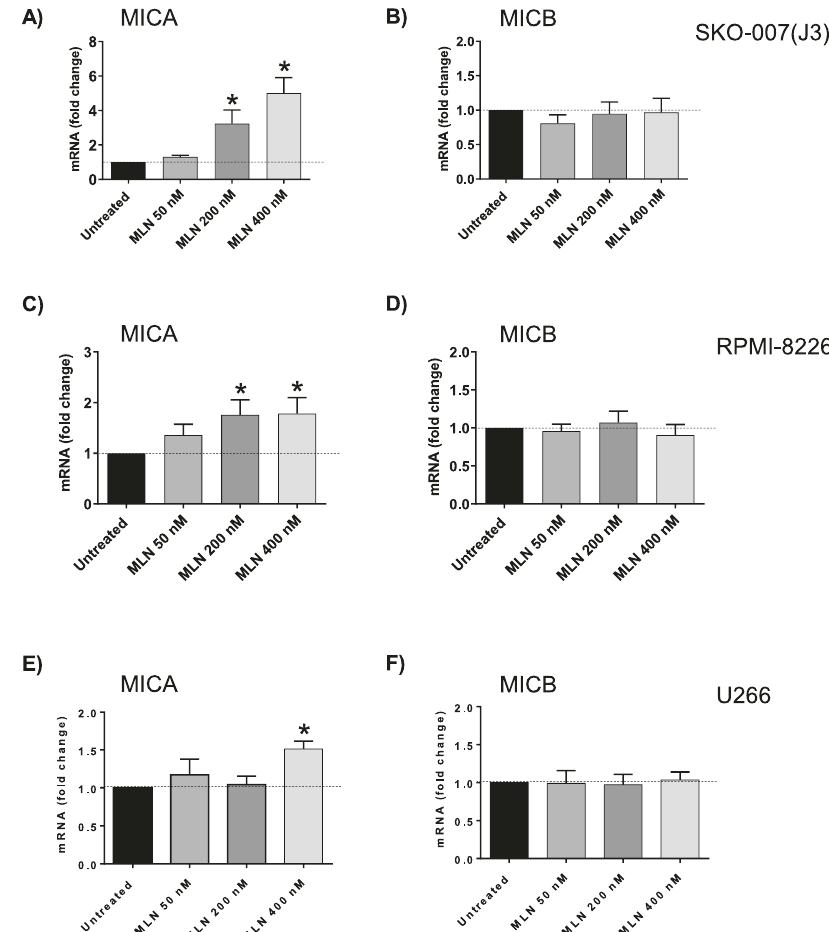
Fig. 2 MLN4924 upregulates MICA but not MICB mRNA levels in human MM cell lines. Real-time PCR analysis of total mRNA extracted from SKO-007(J3), RPMI-8226 and U266 cells, untreated or treated with the indicated concentrations of MLN4924 as described above, for 48 h. (A,C, E) MICA. (B,D,F) MICB. Data, expressed as fold change units, were normalized to GAPDH, and were referred to the untreated sample considered as calibrator (mean ± SEM of four independent experiments * P < the E3-ubiquitin ligase complex CRL4-cereblon (CRL4 CRBN ) [56]. Importantly, MEIS2 has been described by our group as a regulator of proliferation, cell death, and activity of IMiDs in MM, given its ability to regulate the expression of IRF4 and IKZF3, and to act as an endogenous competitor for CRL4 CRBN [47]. We focused our attention on MICA expression (MICB expression is not affected by Lenalidomide in MM cells [35]) and, as shown in Fig. 8E – G, pretreatment with MLN4924 for 24 h followed by stimulation with Lenalidomide signi fi cantly potentiated MICA cell surface and mRNA expression, con fi rming our hypothesis.